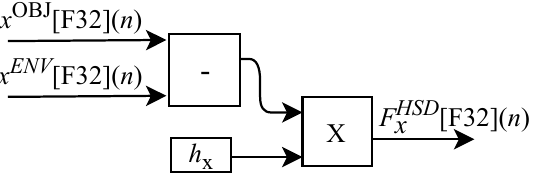
Figure 29. Proposed circuit to calculate the feedback force F HSD x [ F 32 ]( n ) (Equation (60))—FBF-HSD.